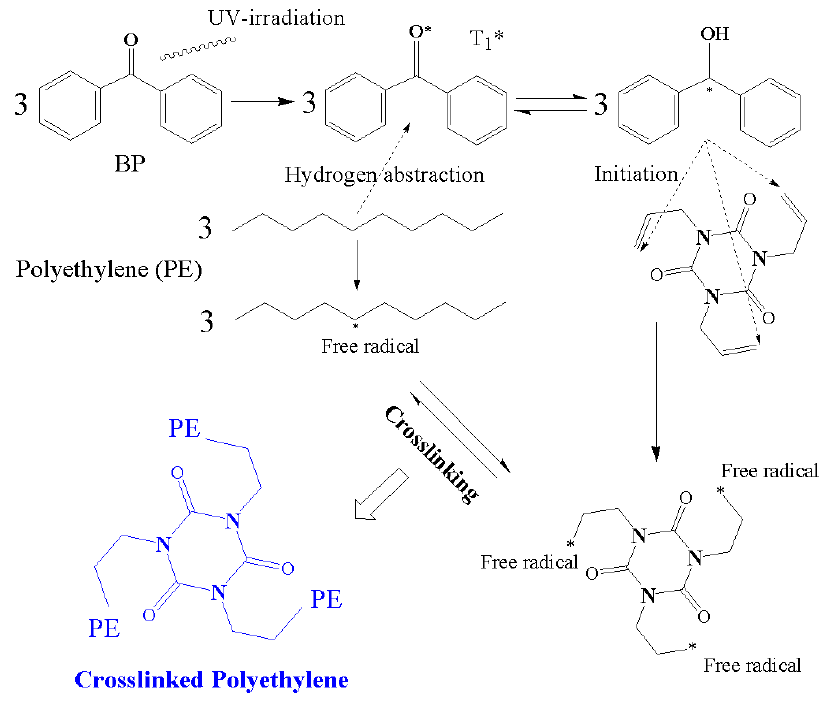
Figure 8. Schematic illustration of ultraviolet (UV)-initiated crosslinking reactions employing auxiliary crosslinkers (TAIC for example).